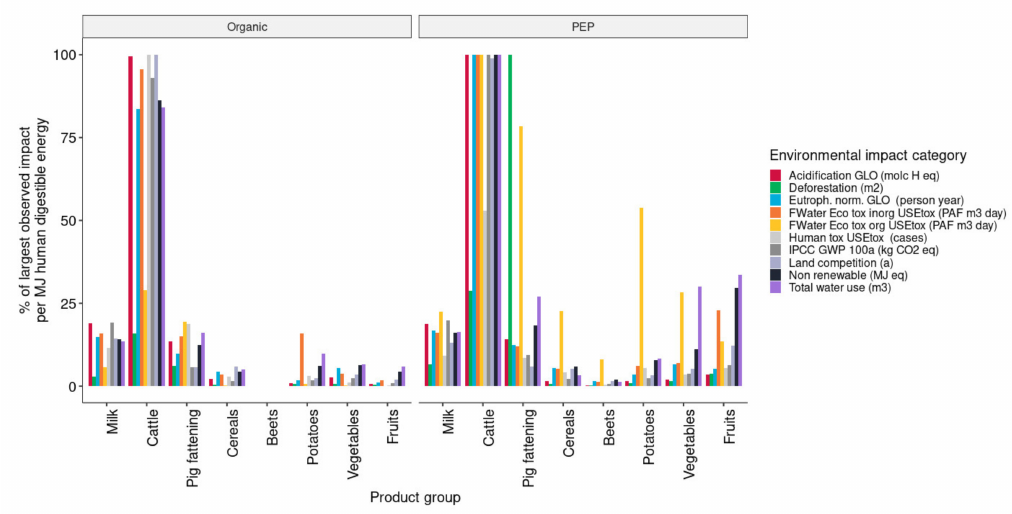
Figure 2. Relative average impact per produced amount of human digestible energy (MJ) for each product group. All values are averaged over all observations and normalized by the largest observed averaged value per impact (largest value = 100%). In order to better illustrate the differences between the two farming systems, the impact “Fresh Water Eco-Toxicity USEtox (PAF m 3 day)” is split into ecotoxicity of organic and inorganic compounds. (PAF m 3 day = potentially affected fraction of species integrated over time and volume, GLO = Global, FWater = Freshwater, eq =